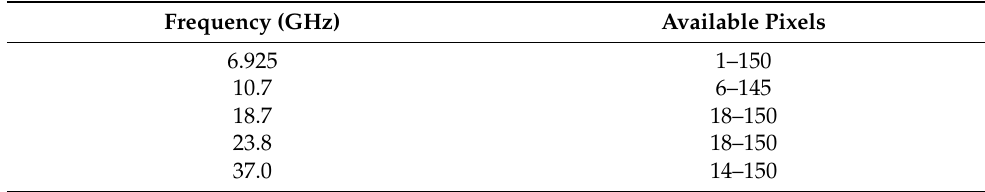
Table 3. Threshold of CLWP and available pixels after resampling to 6.925